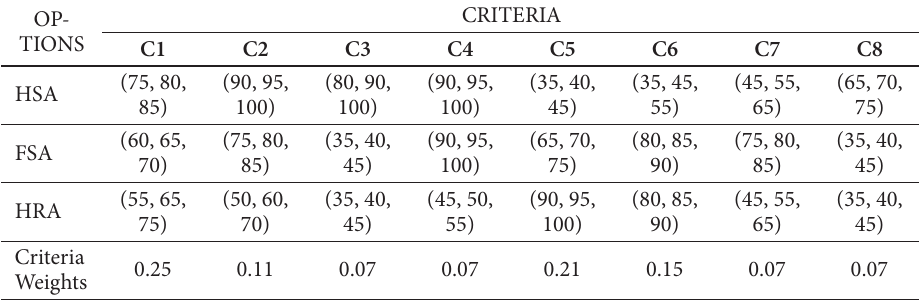
Table 5. Fuzzy decision matrix